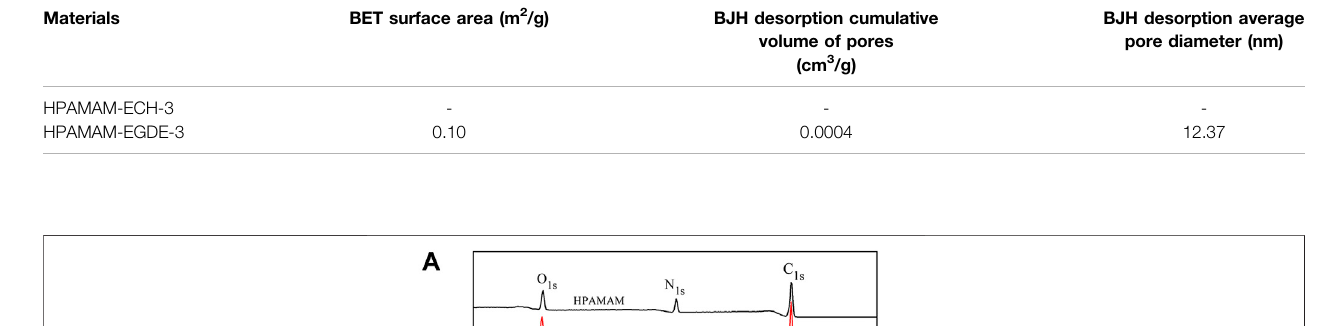
TABLE 2 | The porous structures parameters of HPAMAM-ECH-3 and HPAMAM-EGDE-3. Materials